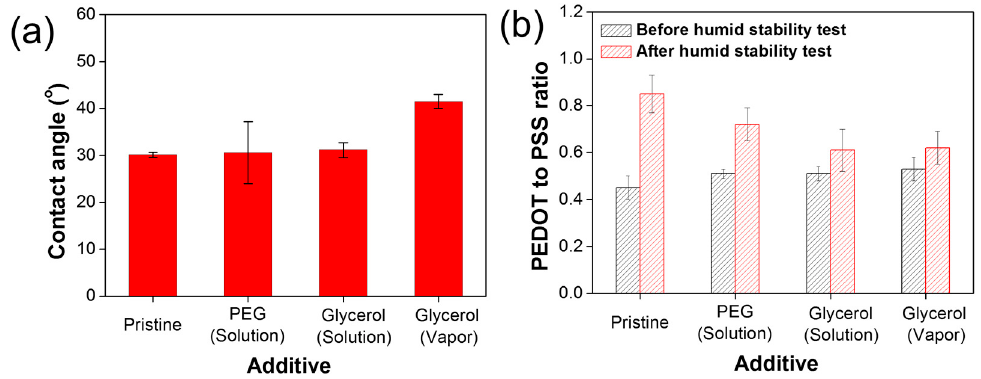
Figure 5. Average values of ( a ) contact angles and ( b ) PEDOT to PSS ratios of Pristine, PEG solution-treated, glycerol solution-treated, and glycerol vapor-treated films; before (0 h) and after humid stability test (288 h).